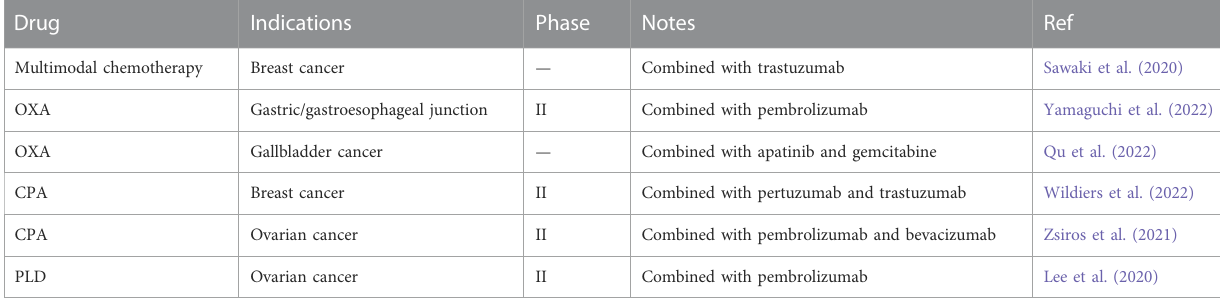
TABLE 2 The recent clinical studies to evaluate the combination of ICD-induced chemotherapy and